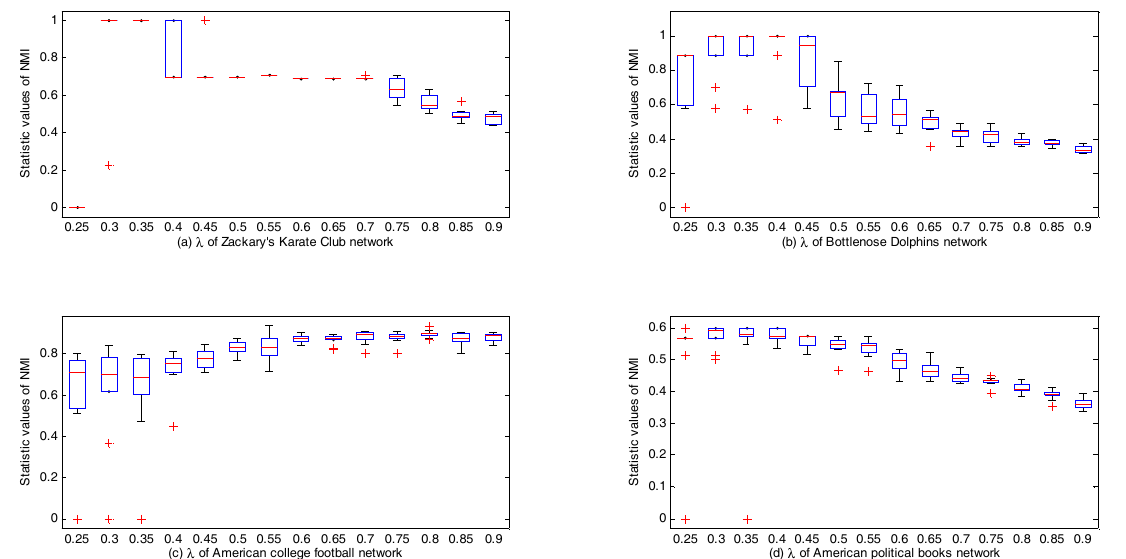
Figure 4. (Color online) Statistical values of normalized mutual information (NMI) over the 10 runs of the community detection approach based on a differential evolution algorithm (CDDEA) on four real-world networks.